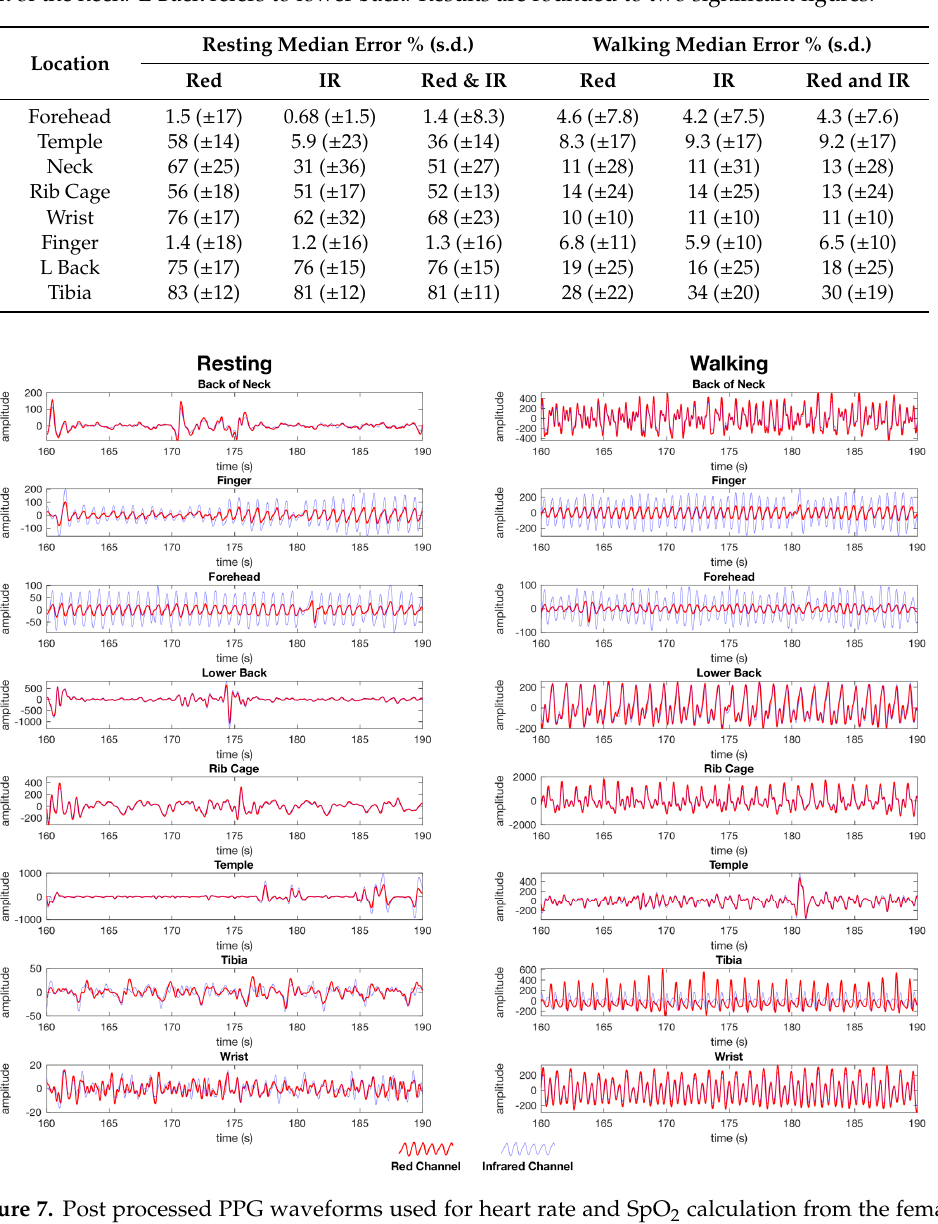
Table 3. Results for heart rate calculation at eight anatomical locations presented as median percentage of error from the expected value as calculated from the commercial pulse oximeter recordings. Data recorded is an average error using 60 s windows of the instantaneous heart rate data for the red, infrared and combined (red and IR) channels. Wrist refers to the posterior distal forearm. Neck refers to the back of the neck. L Back refers to lower back. Results are rounded to two significant figures.